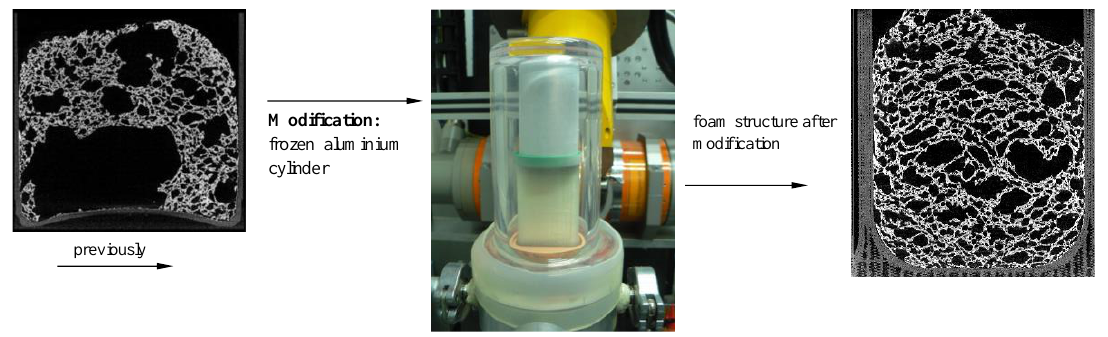
Figure 2. Improvements to the experiment.